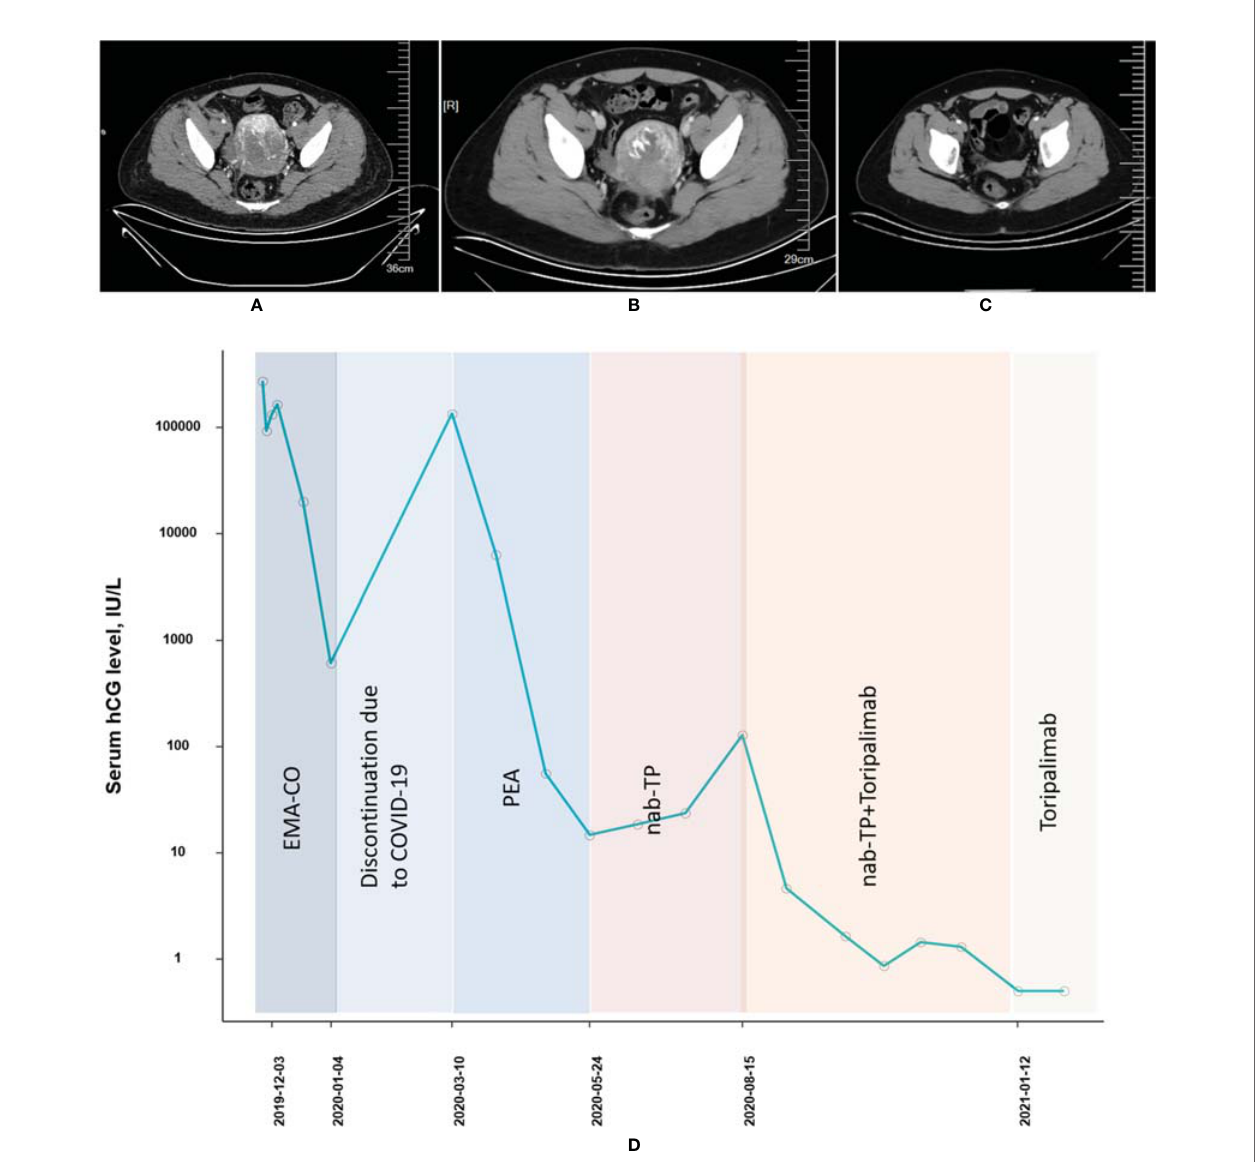
FIGURE 2 | Computed tomography imaging (A) before EMA-CO chemotherapy, (B) after EMA-CO chemotherapy, and (C) after combined treatment of PD-1 and chemotherapies (patient 2). (D) The concentration of the b -hcg level since the diagnosis of choriocarcinoma (patient